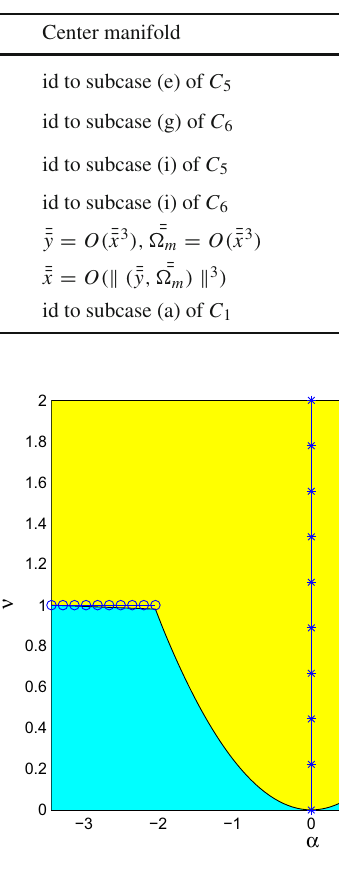
Fig. 2 Stability diagram ( C 7 , C 8